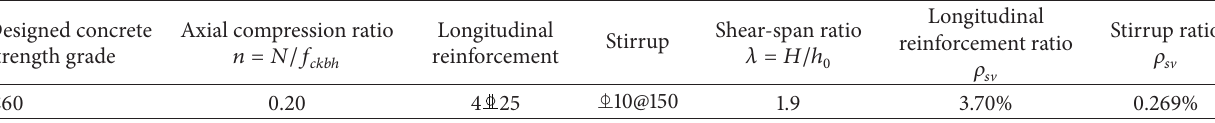
Table 1: Main information of test components in structural test.